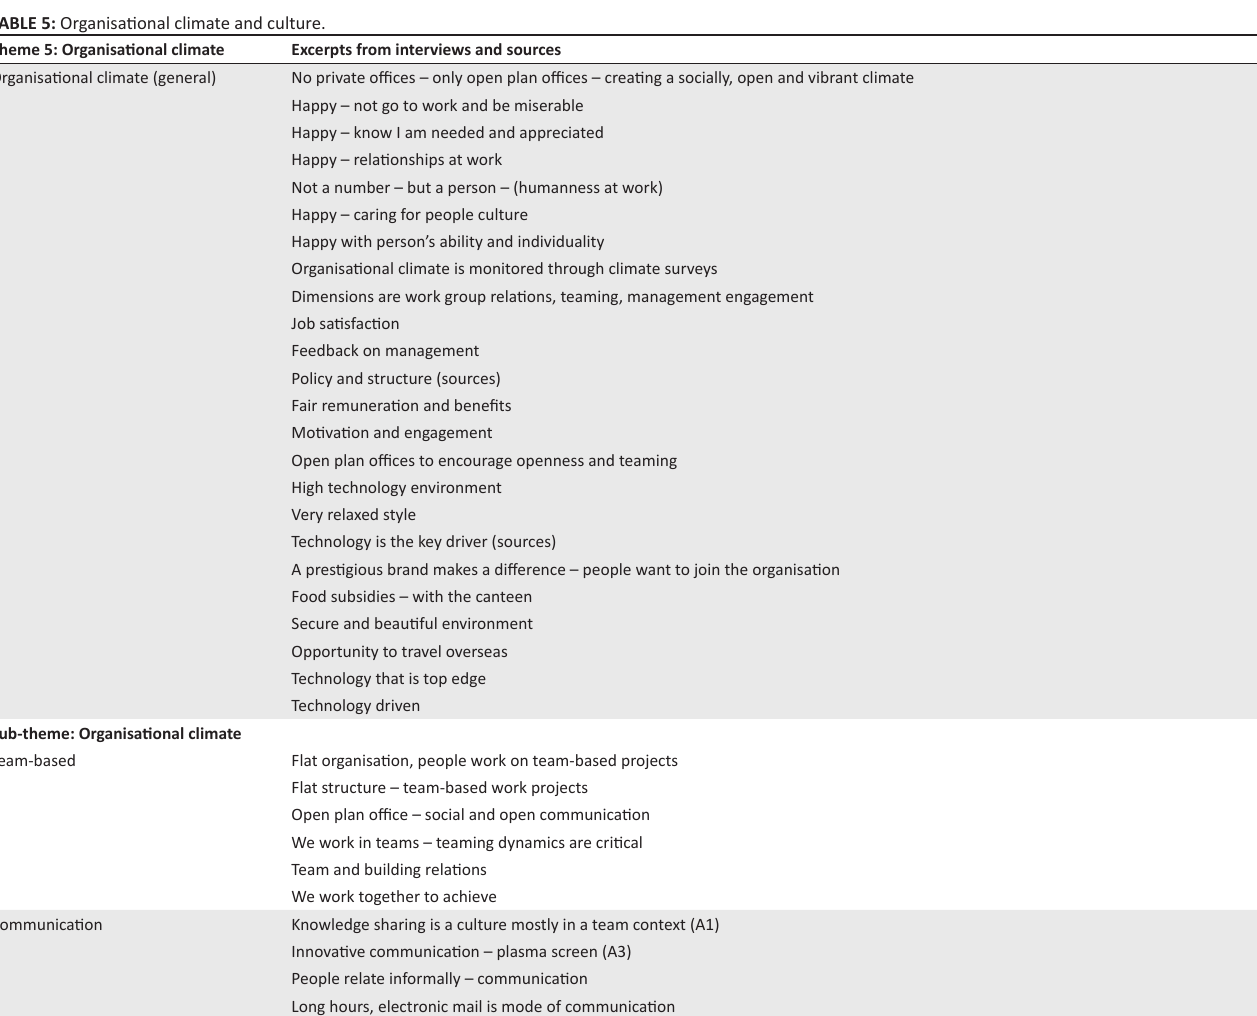
Table 5 continues on the next page →